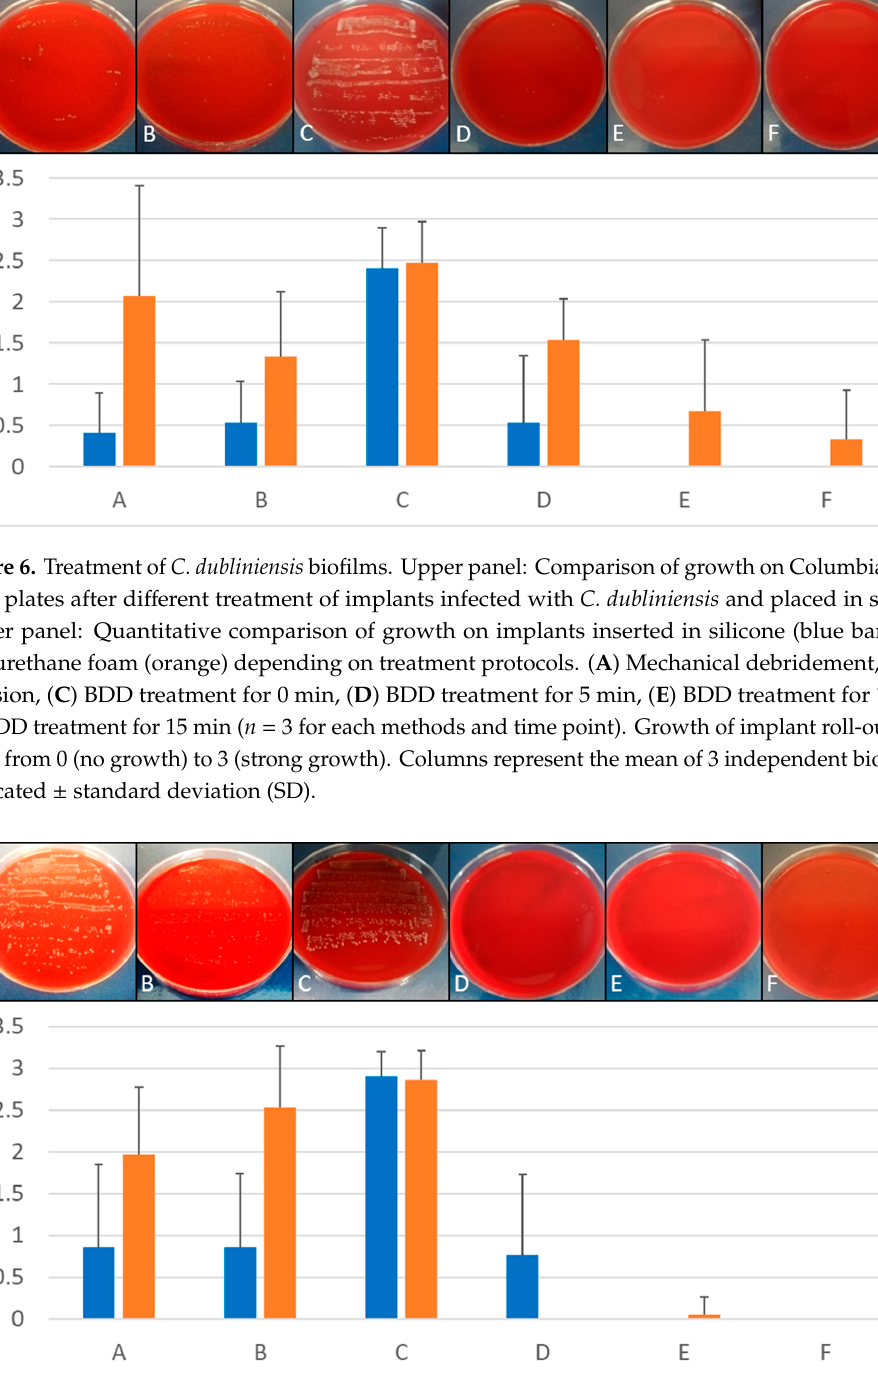
Figure 7. Treatment of E. faecalis biofilms. Upper panel: Comparison of growth on Columbia Blood Agar plates after di ff erent treatment of implants infected with E. faecalis and placed in silicone. Lower panel: Quantitative comparison of growth on implants inserted in silicone (blue bars) and polyurethane foam (orange bars) depending on treatment protocols. ( A ) Mechanical debridement, ( B ) air abrasion, ( C ) BDD treatment for 0 min, ( D ) BDD treatment for 5 min, ( E ) BDD treatment for 10 min, ( F ) BDD treatment for 15 min ( n = 3 for each methods and time point). Growth of implant roll-outs was rated from 0 (no growth) to 3 (strong growth). Columns represent the mean of 3 independent biological replicated ± standard deviation